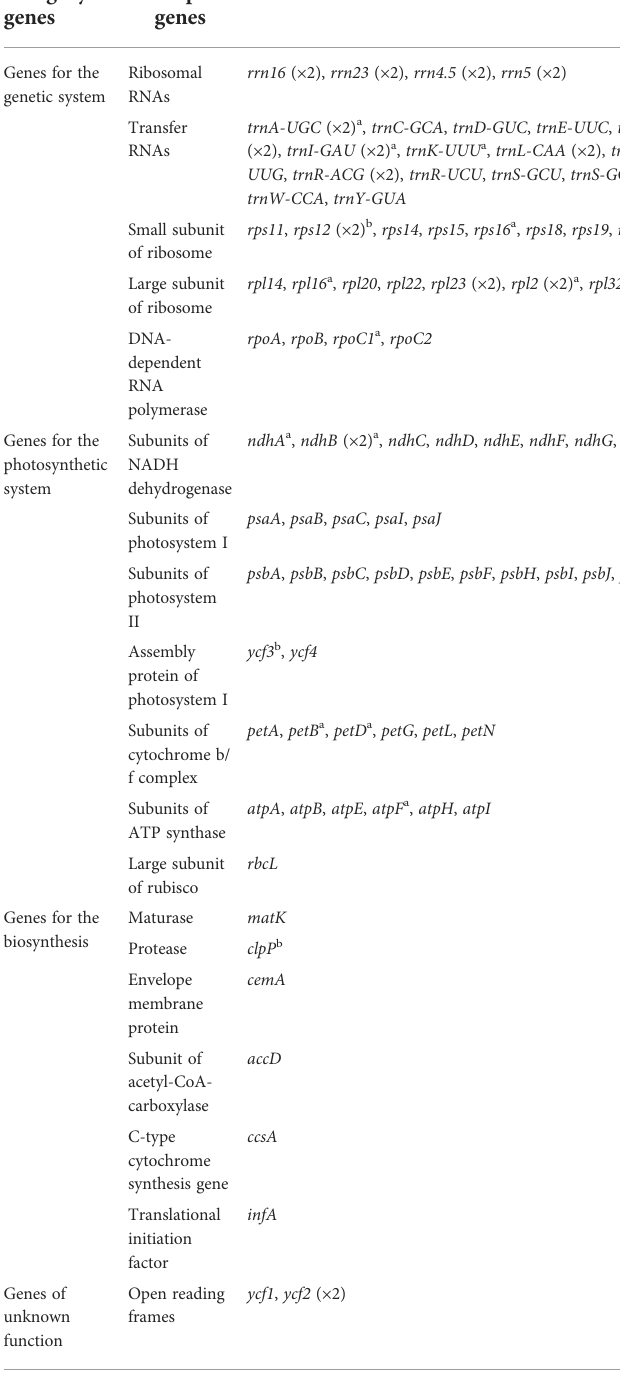
TABLE 3 Gene contents in the Sabia chloroplast genomes. Category of Group of genes genes Genes for the Ribosomal genetic system